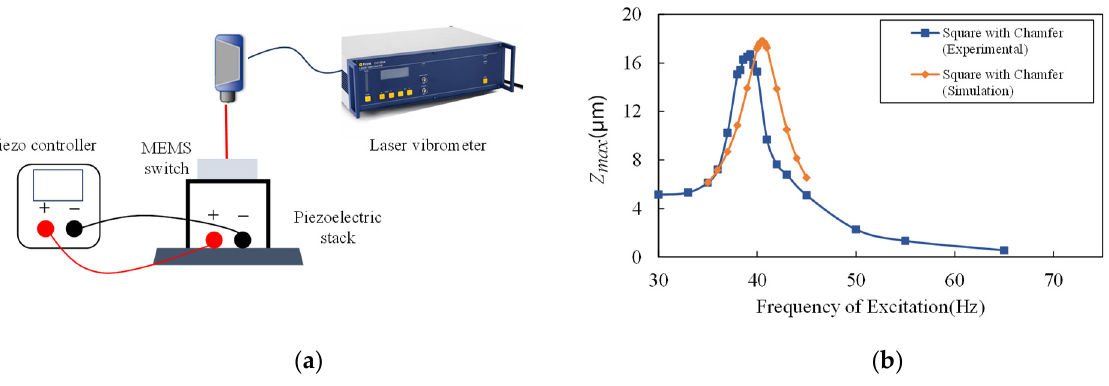
Figure 12. ( a ) The experimental setup of the piezoelectric stack; ( b ) comparison of the simulation result and the experimental result of the relative displacement versus the excitation frequency.